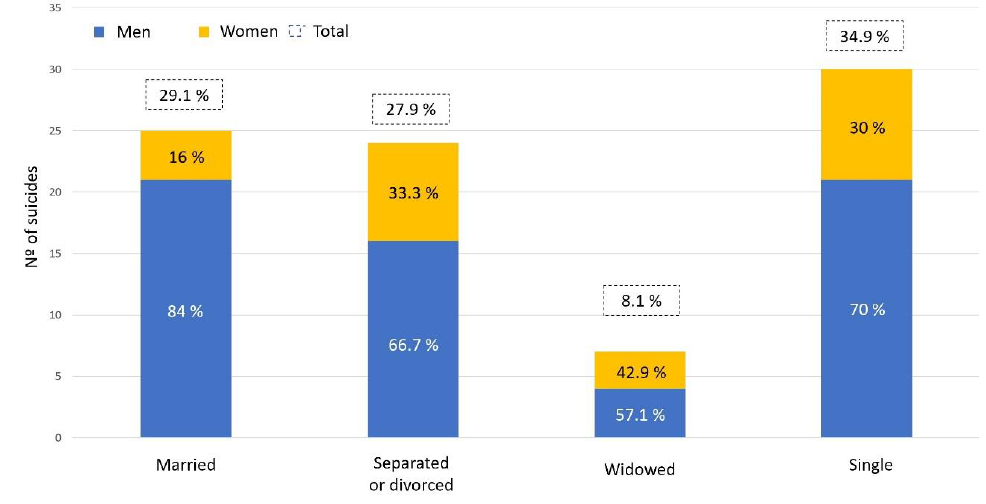
Figure 2. Graphical representation of the marital status of the study sample. Table 1. Comparison of proportions between cases in our sample and the Spanish population (ac- cording to INE’s data ).